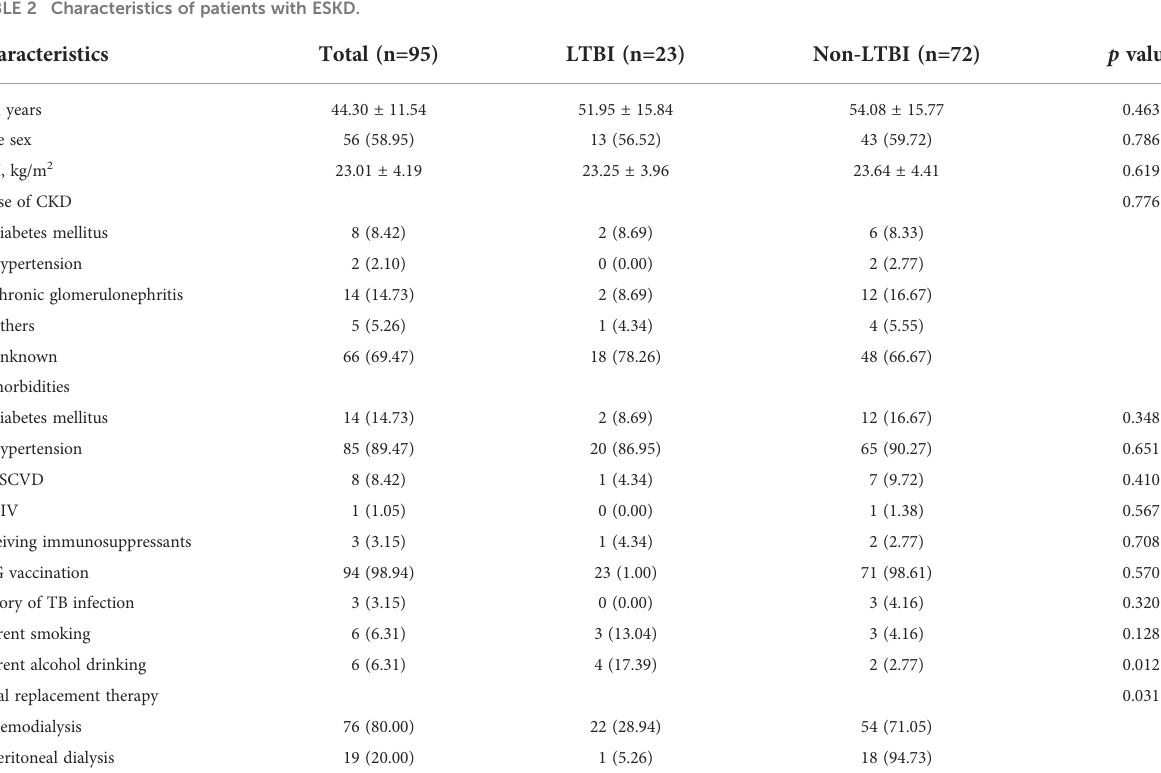
TABLE 2 Characteristics of patients with